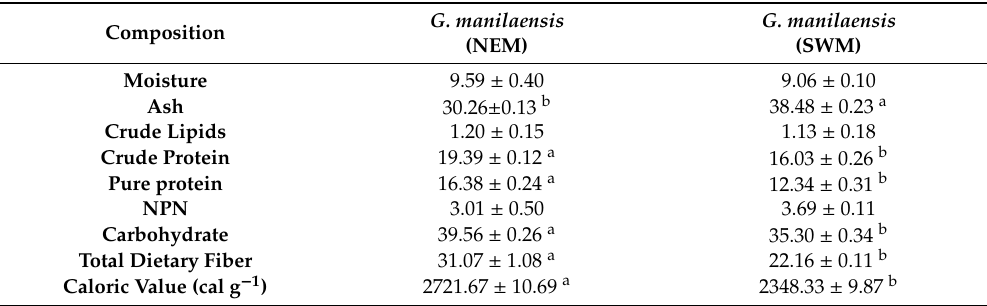
Table 1. Variation in Proximate Composition (g 100 g − 1 DW) and Gross Calorific Value (cal g − 1 ) Of G. manilaensis Collected in Johor, Malaysia.